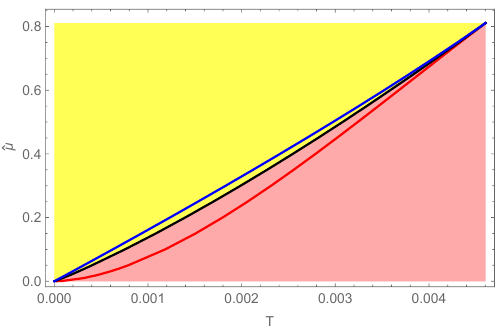
Figure 7 . Phase diagram in ˆ µ − T plane. In this plot, q = 50 and J = 1 . phase is thermodynamically favored in the yellow region, while the two black hole phase is thermodynamically favored in the pink region. For specific coupling constant ˆ µ , there is a temperature window T < T < T in which three phases coexist and the free energy 1 2 landscape has the shape of double well. Varying the parameter ˆ µ , we can get T and T 1 2 as the function of ˆ µ . These two curves T (ˆ µ ) and T (ˆ µ ) are plotted in blue and red in 1 2 figure 7. There is also a phase transition temperature, which is plotted in black. The phase transition temperature is determined by equal free energies of the two basins. The black line represents the coexistence curve that the stable wormhole phase and the two black hole phase coexist in equal probability. When ˆ µ → 0 or ˆ µ increases, the temperature window closes. It is shown there is a critical point as in the gas-liquid phase transition of van der Waals fluid. At the critical point, ˆ µ = 0 . 811 , and T = 0 . 0046 . This behavior is analogous to the van der Waal type phase transition in